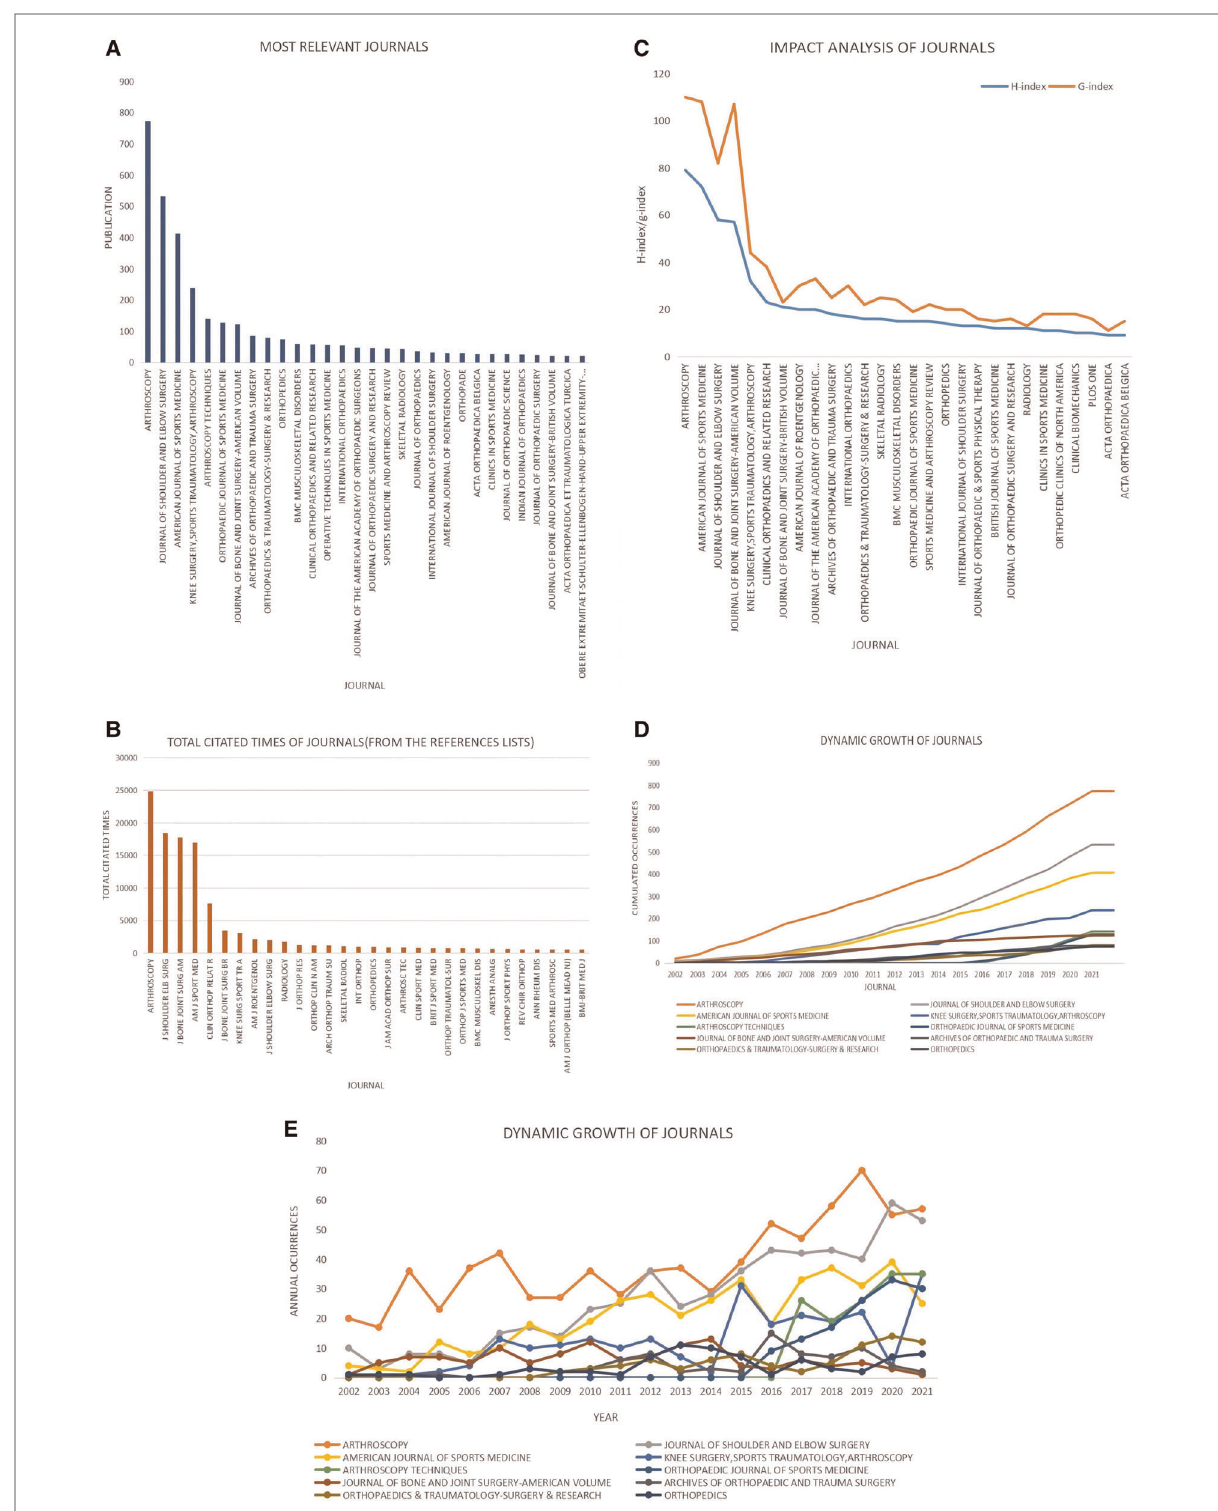
FIGURE 5 Journal analysis of arthroscopic therapy of rotator cuff diseases related publications from 2002 to 2021. ( A ) The number of publications of the top 30 most relevant journals. ( B ) The total cited times of the top 30 most relevant journals (Analysis based on the list of references). ( C ) The H-index and G- index of the top 30 most relevant journals. ( D ) The dynamic growth of top 10 journals (Analysis based on the cumulated occurrences). ( E ) The dynamic growth of top 10 journals (Analysis based on the annual